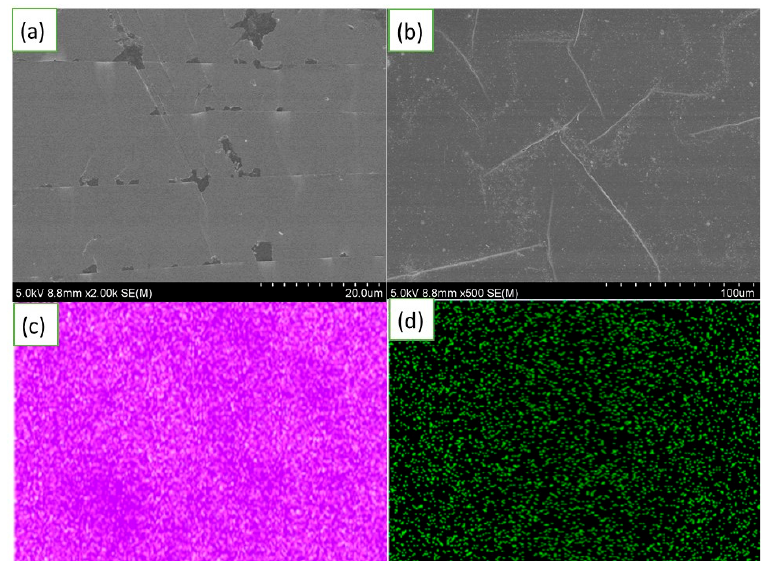
Figure 3. ( a , b ) The SEM images of 2D MoS 2 nanosheets deposited on PET/ITO at different scale pars. EDX for ( c ) S, and ( d ) Mo, respectively, for the 2D MoS 2 nanosheets.